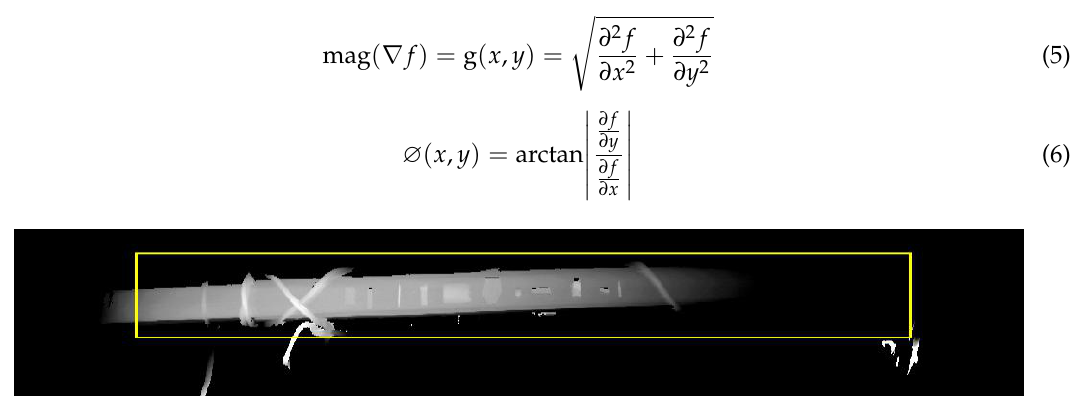
Figure 16. Strength images.